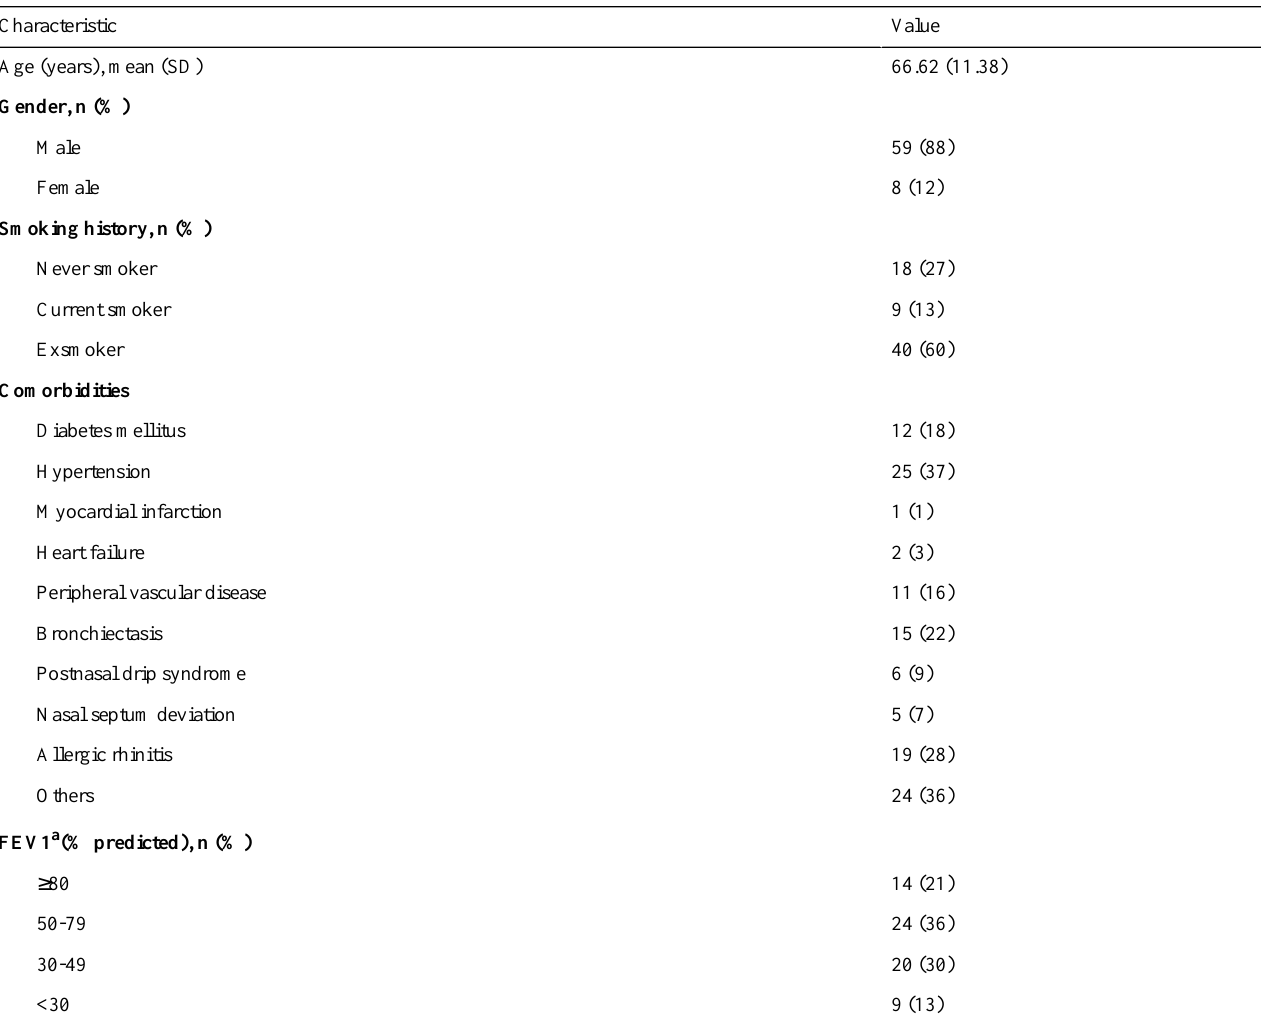
Table 2. Demographics of study participants (N=67).